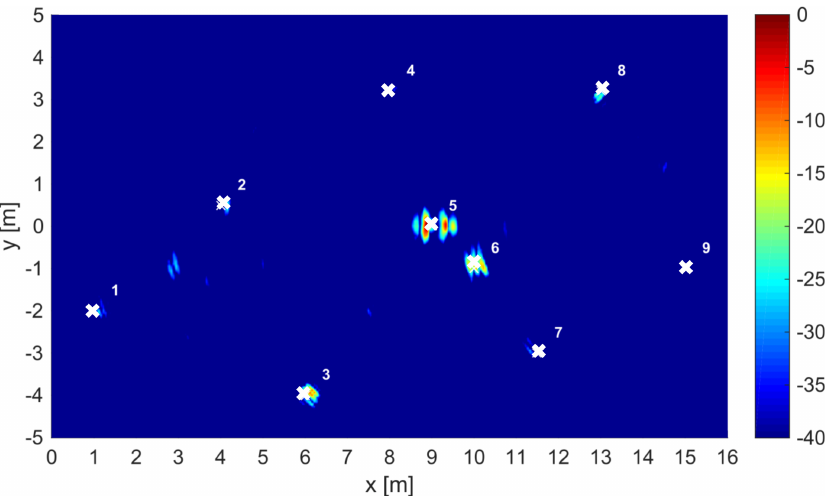
Figure 12. MF Image of Figure 5 corrected via phase coherence factor (PCF).